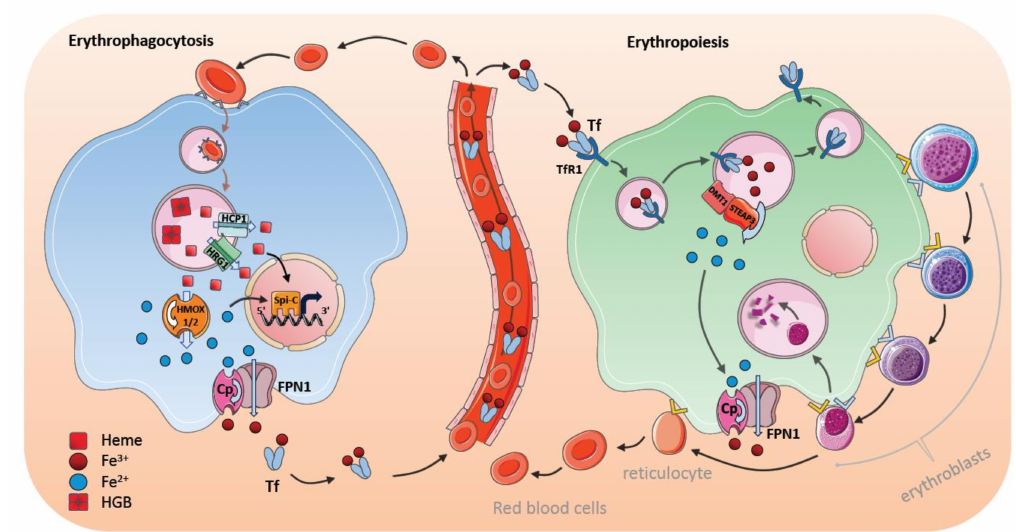
Figure 3. Macrophages in erythrophagocytosis and erythropoiesis. The majority of iron in a macrophage is obtained during erythrophagocytosis. Splenic red pulp macrophages (RPMs) and liver Kupffer cells (KCs) is the main source of iron in the body. Senescent red blood cells (RBCs) are recognized by macrophages and digested in the lysosomes. Heme is extracted in the phagolysosomes and transferred to the cytosol by heme transporters heme-carrier protein 1 (HCP1) and heme responsive gene 1 protein (HRG1). Heme degradation by heme oxygenase 1 (HMOX1) in the cytosol provides ferrous iron that enters the intracellular labile iron pool. Iron is either stored in ferritin or exported by ferroportin 1 (FPN1) and ceruloplasmin (Cp). The transcription factor (Spi-C) protects iron processing RPMs in the spleen and BM nurse macrophages. Central nurse macrophages in the bone marrow